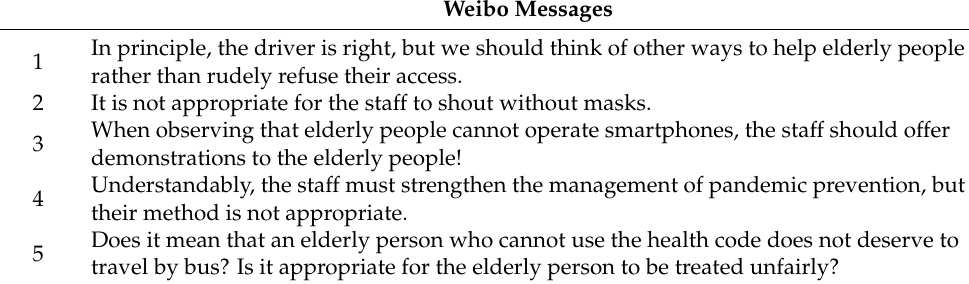
Table 2. Example messages regarding Topic